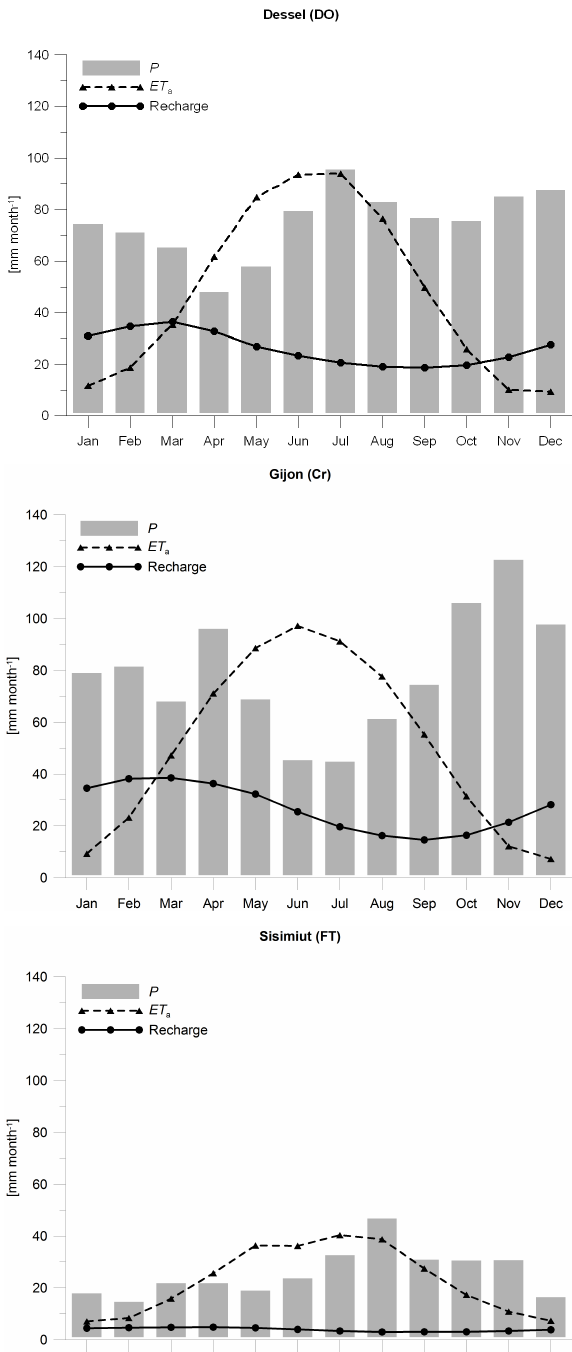
Fig. 2. Monthly average precipitation ( P ), actual evapotranspiration (ET a ) and groundwater recharge for the analogue stations of Dessel (DO, top), Gijon (Cr, middle) and Sisimiut (FT, bottom).